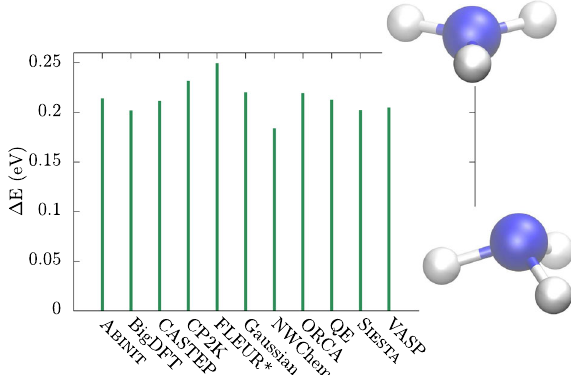
Fig. 4 Energy difference between the planar and pyramidal phases of ammonia. Energy difference ( Δ E ) between the planar and pyramidal phases of ammonia, calculated with the eleven quantum engines reported in the horizontal axis (QE stands for Quantum ESPRESSO). A relaxation of the structure has been performed independently by every code before computing the energies (except for FLEUR*, because for FLEUR the relaxation failed due to overlapping muf fi n-tin spheres, a method-speci fi c issue requiring error handling. The energy difference for FLEUR was calculated through the common work fl ow without relaxation, using the relaxed output structures of Quantum ESPRESSO